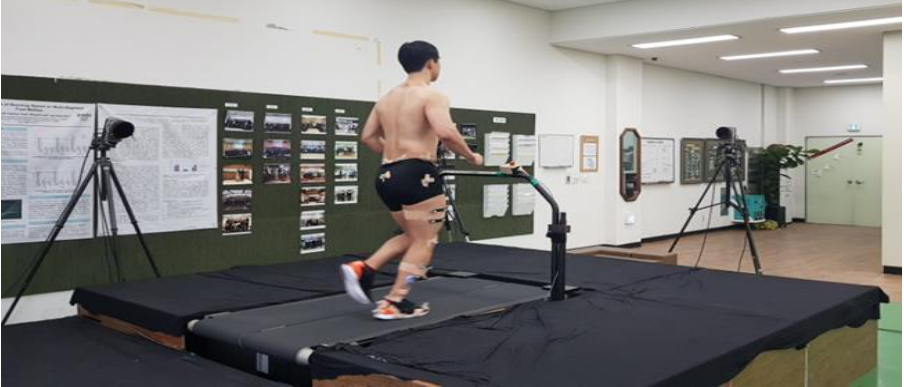
Figure 3. Experimental setup for running on a treadmill.